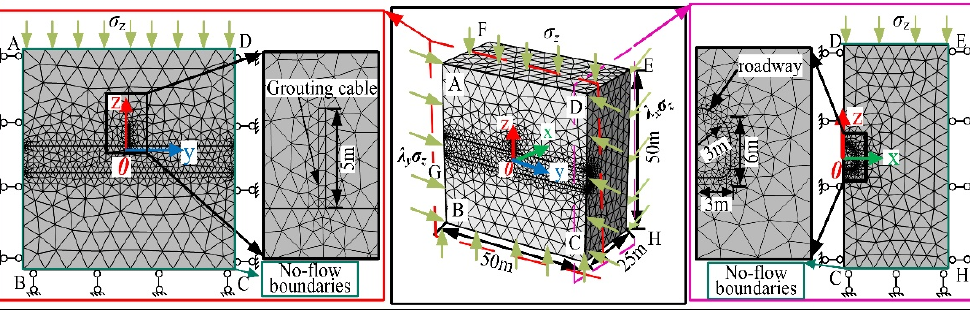
Figure 1. Unidirectional coupling numerical model. Table 1. Physical and mechanical parameters of the surrounding rock and grout.